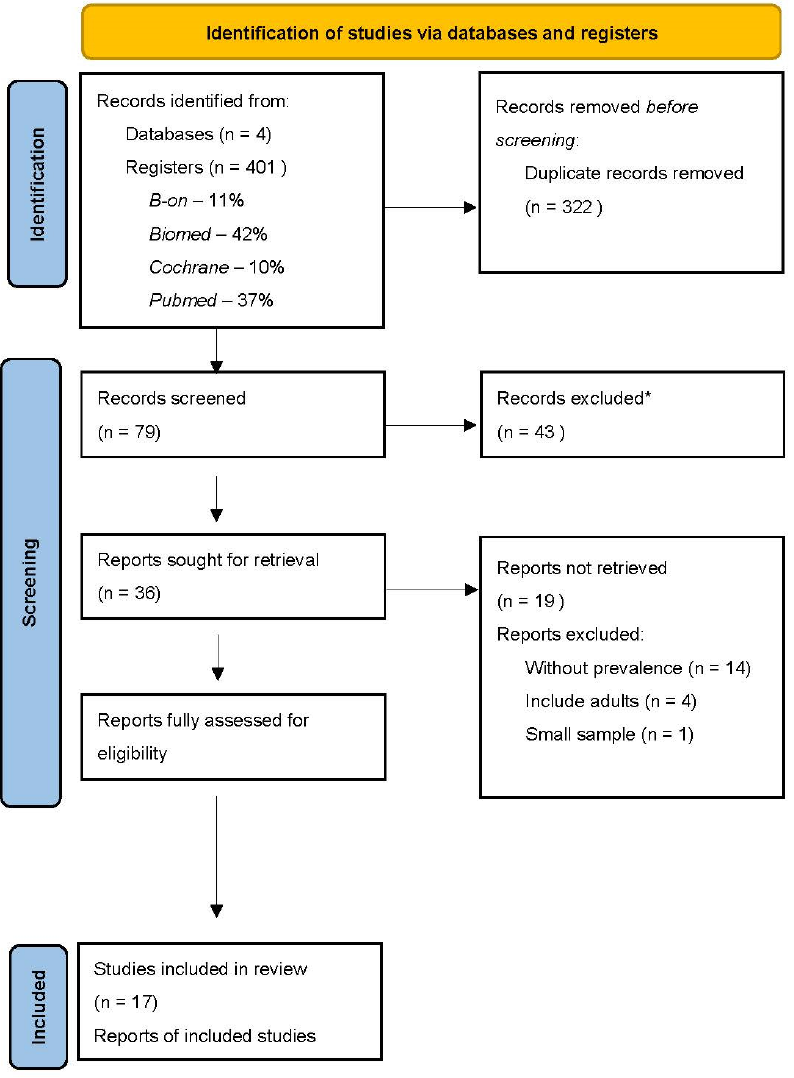
Figure 1. PRISMA flow chart illustrating the review search and screen process. n—number of records. * Articles excluded after reading the title and abstract do not correspond with the review of the theme subject.